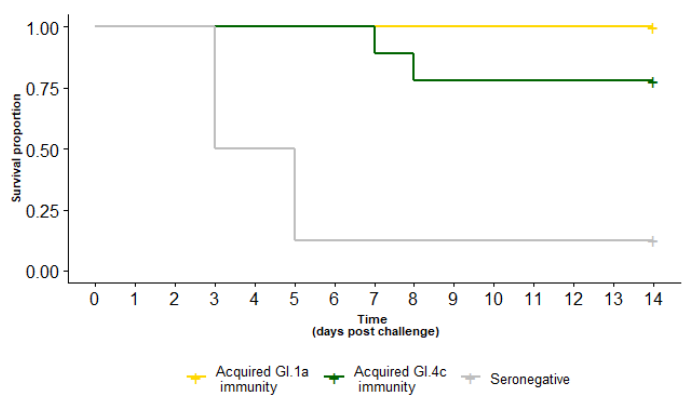
Figure 3. Survival curve of rabbits with experimentally acquired GI.1a (yellow) or GI.4c (green) immunity compared to seronegative (grey) rabbits after a GI.2 challenge (50 RID 50 PO). Immunity with either GI.1a or GI.4c variants provided significant cross-protection against GI.2 challenge.